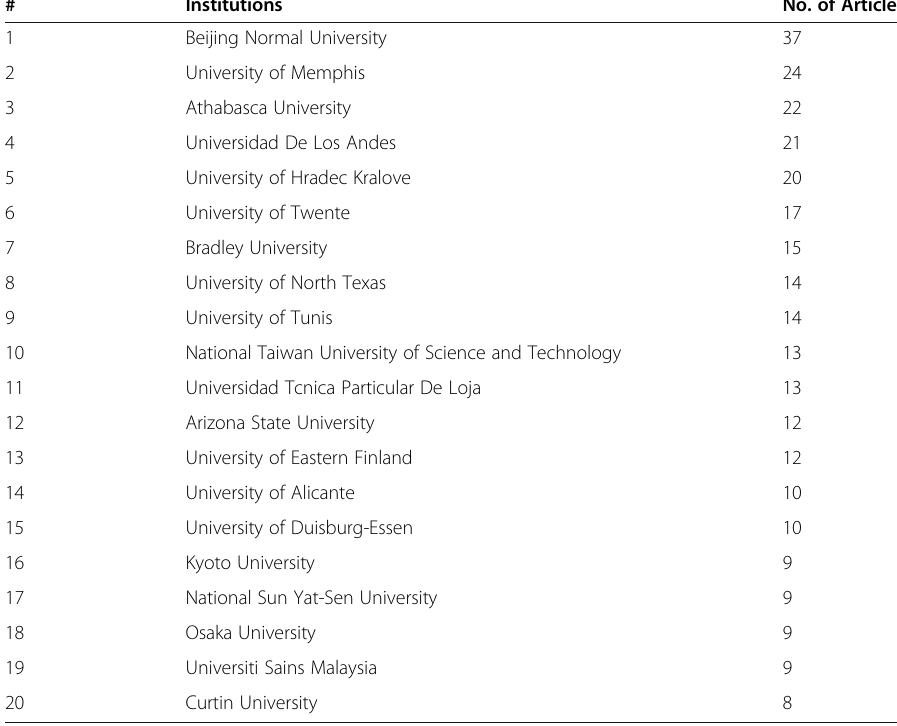
Table 7 Most relevant institutions in the field of smart learning environment # Institutions No. of